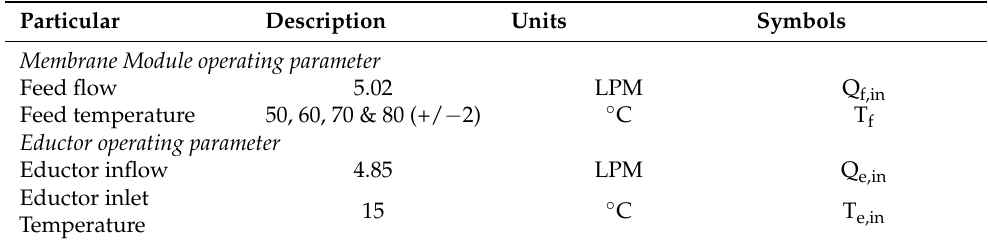
Table 4. Operating parameters of the hybrid system.